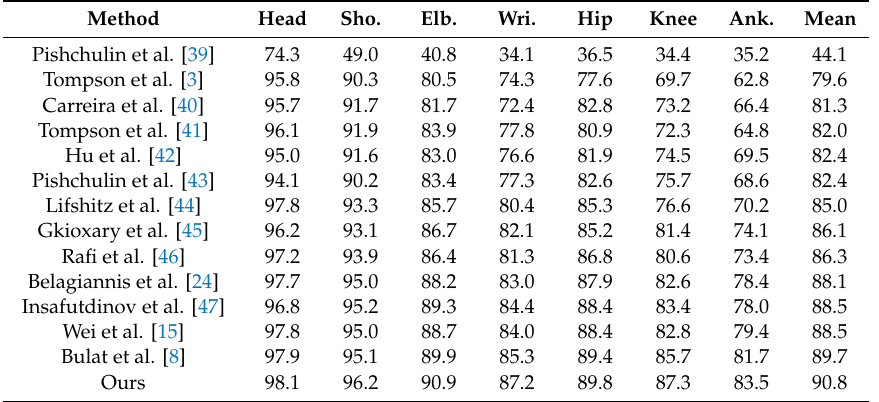
Table 6. Accuracy comparison with existing methods using the MPII validation dataset (PCKh@0.5).